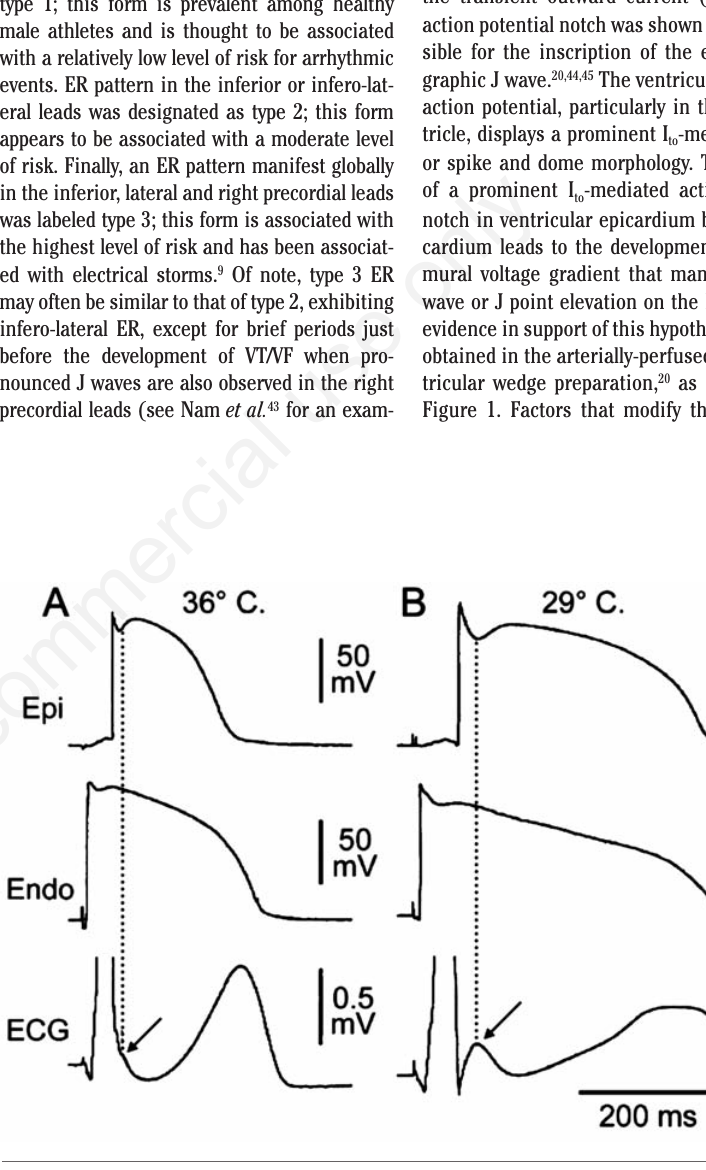
Figure 1. Hypothermia-induced J wave. Each panel shows transmembrane action poten- tials from the epicardial and endocardial regions of an arterially perfused canine left ven- tricular wedge and a transmural electrocardiogram (ECG) simultaneously recorded. A) The relatively small action potential notch in epicardium but not in endocardium is asso- ciated with an elevated J-point at the R-ST junction (arrow) at 36°C. B) A decrease in the temperature of the perfusate to 29°C results in an increase in the amplitude and width of the action potential notch in epicardium but not endocardium, leading to the develop- ment of a transmural voltage gradient that manifests as a prominent J wave on the ECG (arrow) ( modified from Yan and Antzelevitch, 1996 20 with permission